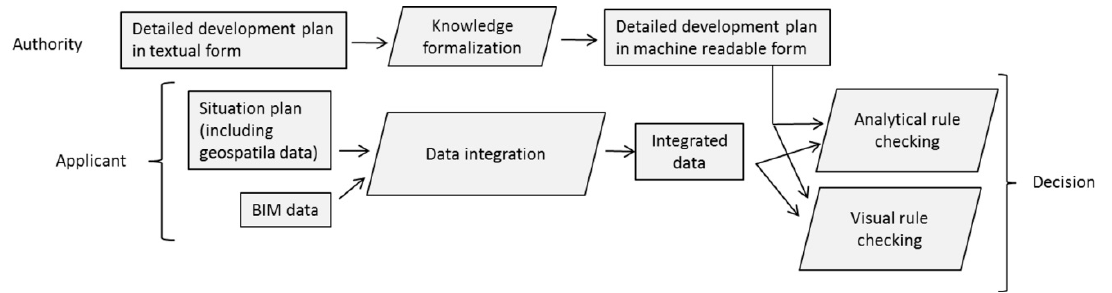
Figure 1. Outline of the main steps in an automated building permission process.